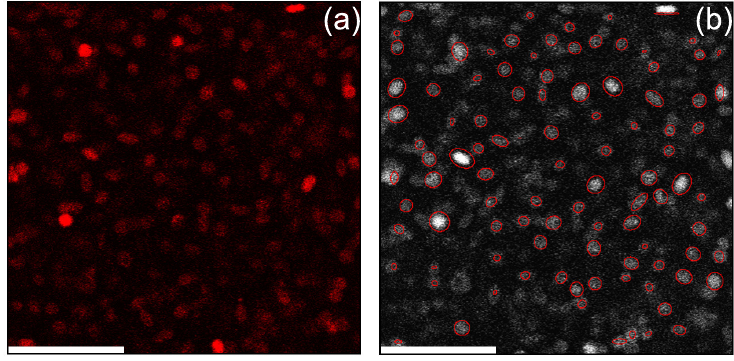
Figure 6. ( a ) A raw confocal slice through a fluid bulk suspension of PCPMMA ellipsoids. Note the brightness of the particles, achieved by a swelling/deswelling fluorescent staining, carried out after particle stretching; such staining is impossible with the conventional PMMA ellipsoids [3,4,7]. While our confocal images deal with a fluid of mobile particles, so that resonant scanning and piezo-z positioning had to be employed, much higher quality images of similar particles have been recently obtained for static PCPMMA ellipsoids, residing at the bottom of a sample chamber [18], where much slower galvanometric confocal scanning is possible. ( b ) The same image, with the positions and the orientations of the particles, as detected by our algorithm, marked by red ellipses. Note that all particles that are not perfectly parallel to the optical slice appear more rounded than they actually are. The scale bar length is 14 µ m, in both